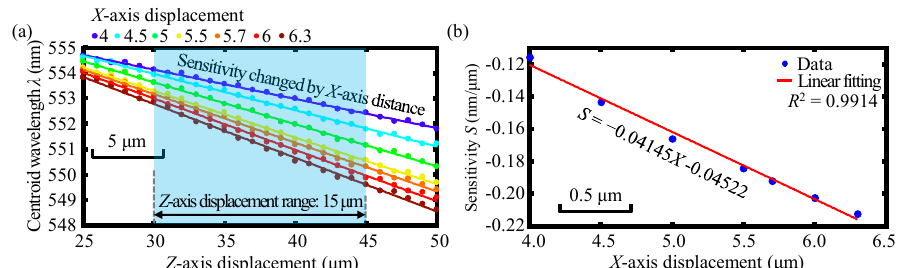
Figure 6. Simulation results of ( a ) the linear relationship between the centroid wavelength λ and Z -axis displacement and ( b ) the linear relationship between the corresponding sensitivity S ( λ - Z curve slope) and X -axis displacement at the X -axis displacements from 4 to 6.3 μm.